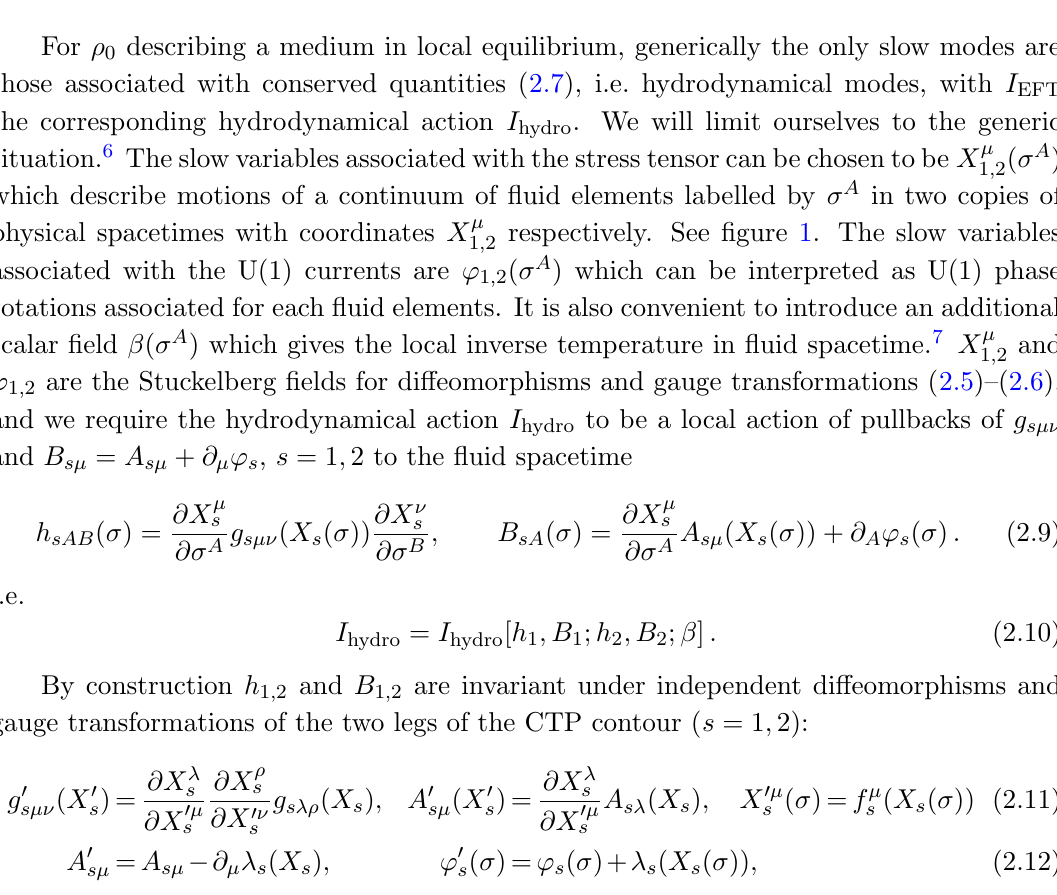
Figure 1 . X (cid:22) ( (cid:27) A ) describe motion of a continuum of (cid:13)uid elements labelled by (cid:27) A in two copies 1 ; 2 of physical spacetimes with coordinates X (cid:22) respectively. (cid:27) A = ( (cid:27) 0 ; (cid:27) i ) are coordinates for a \(cid:13)uid 1 ; 2 spacetime", where (cid:27) i are interpreted as labels of each (cid:13)uid element while (cid:27) 0 is their \internal" time. The red straight line in the (cid:13)uid spacetime with constant (cid:27) i is mapped by X (cid:22) ( (cid:27) 0 ; (cid:27) i ) to 1 ; 2 physical spacetime trajectories (also in red) of the corresponding (cid:13)uid